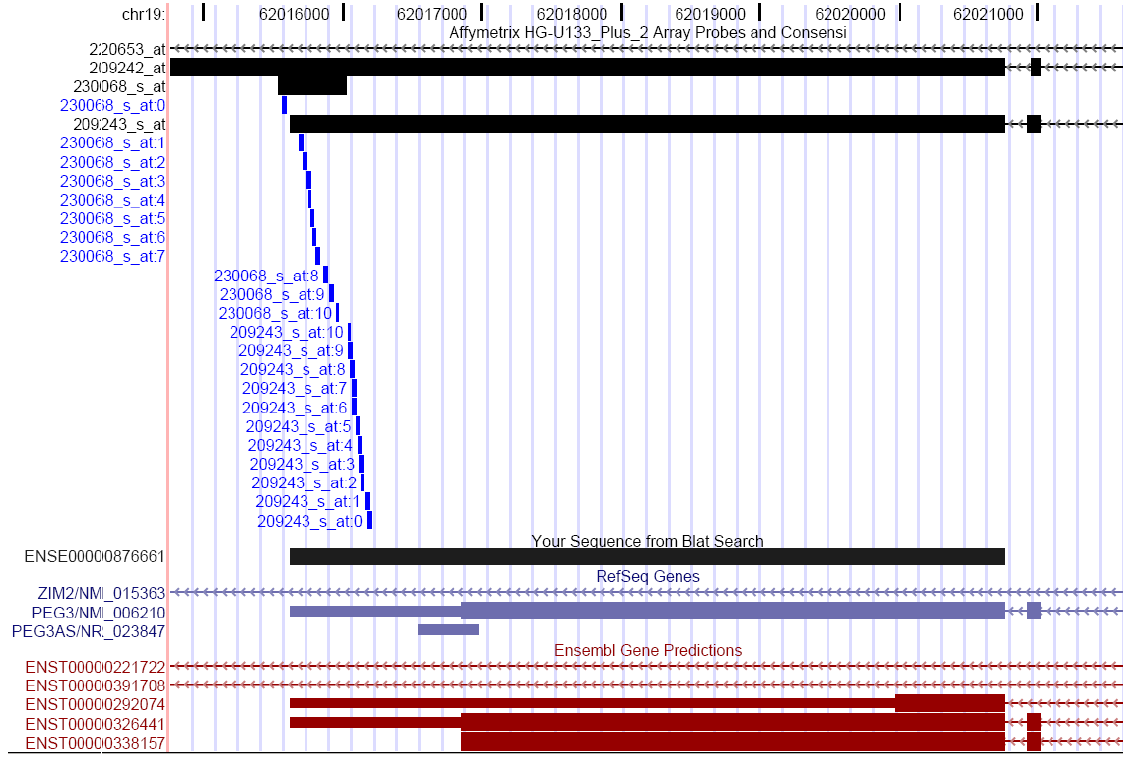
Figure S1. UCSC screen shot for